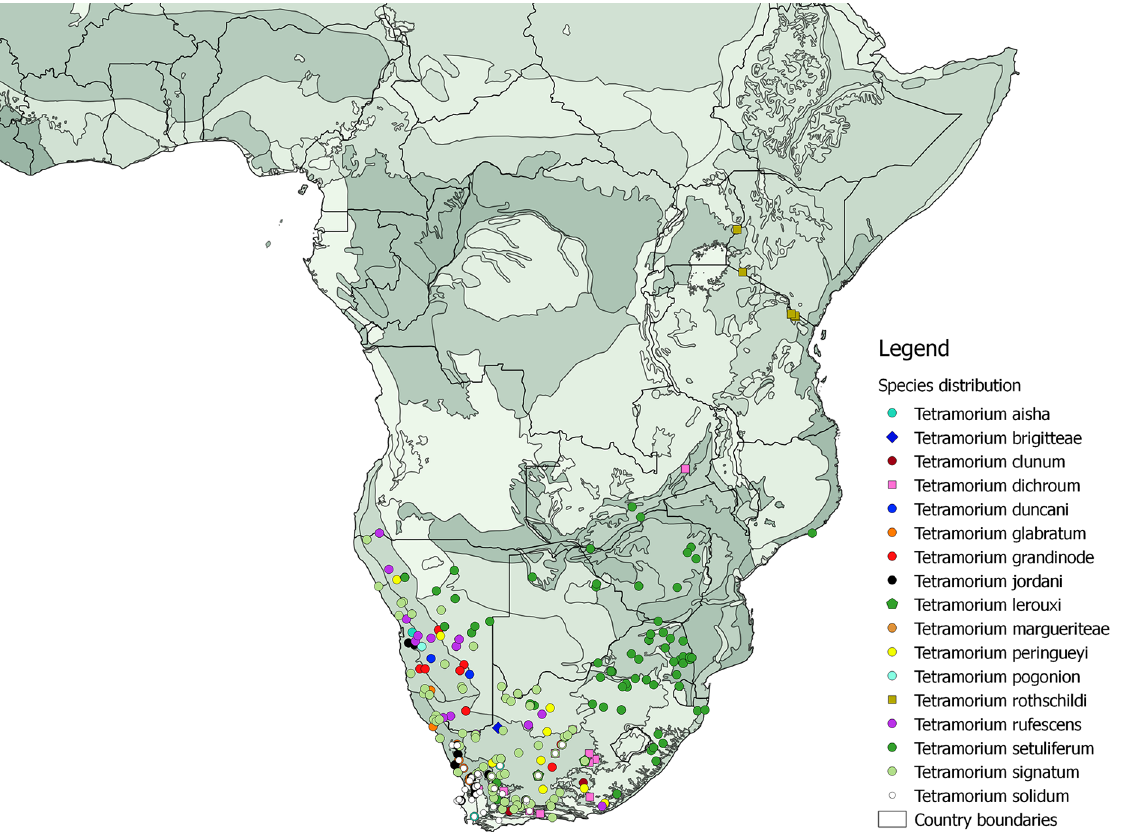
Fig. 24. Map showing the distribution of species in the Tetramorium solidum